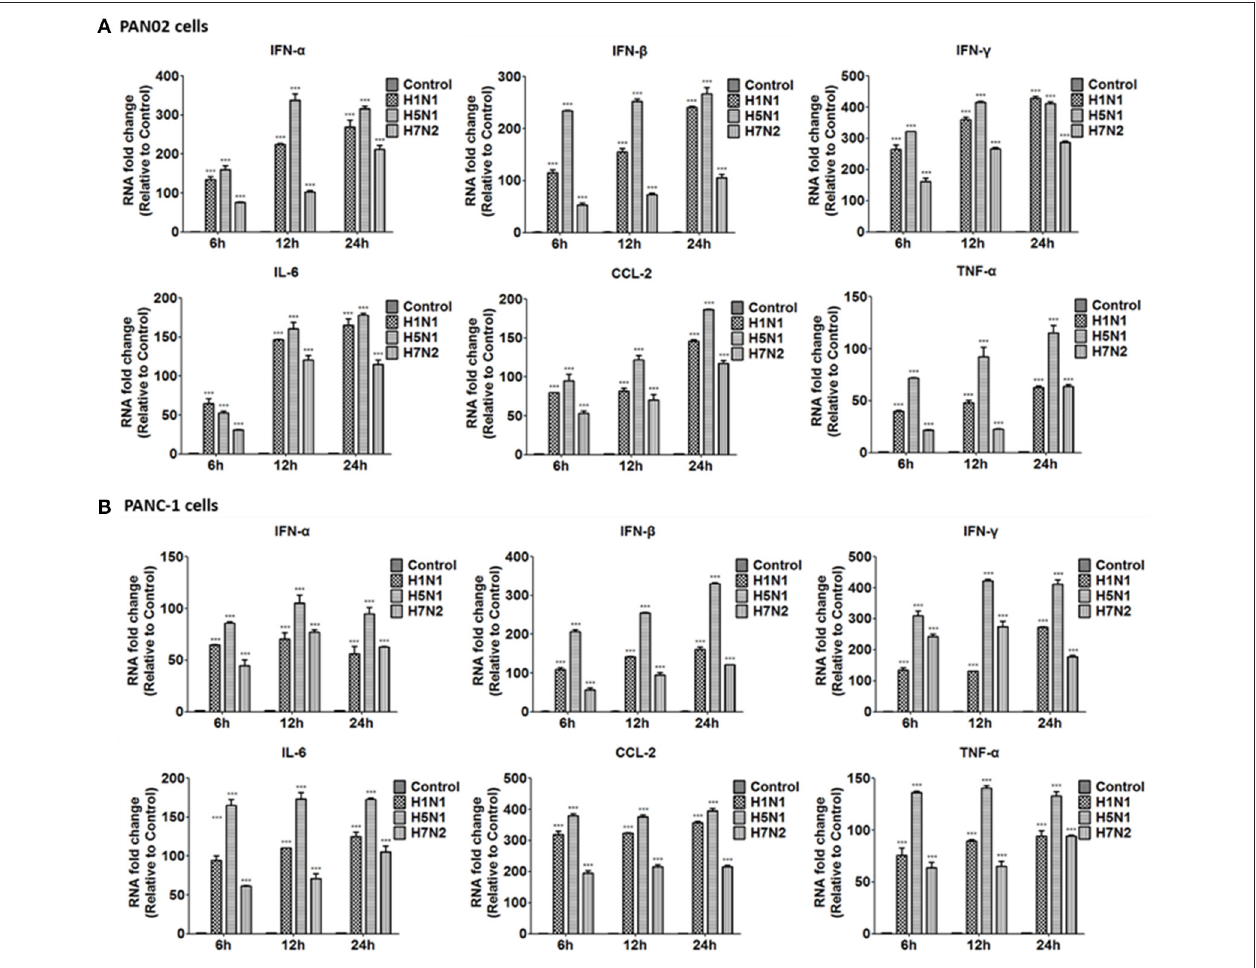
FIGURE 8 | H5N1 IAV infection increased the release of pro-inflammatory cytokines and chemokines outside the cells to function. (A) PAN02 and (B) PANC-1 cells were treated or infected as described in Figure 5 and the culture media supernatant were harvested at 6, 12, and 24h post-infection. The expression of